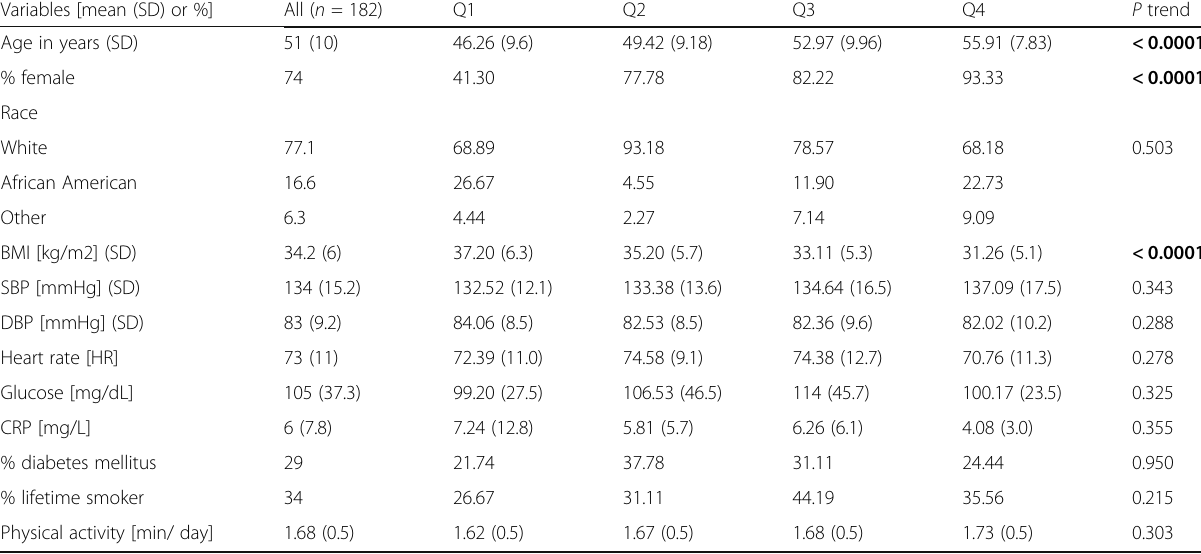
Table 1 Descriptive characteristics of the study population along the quartiles of augmentation index (Al).